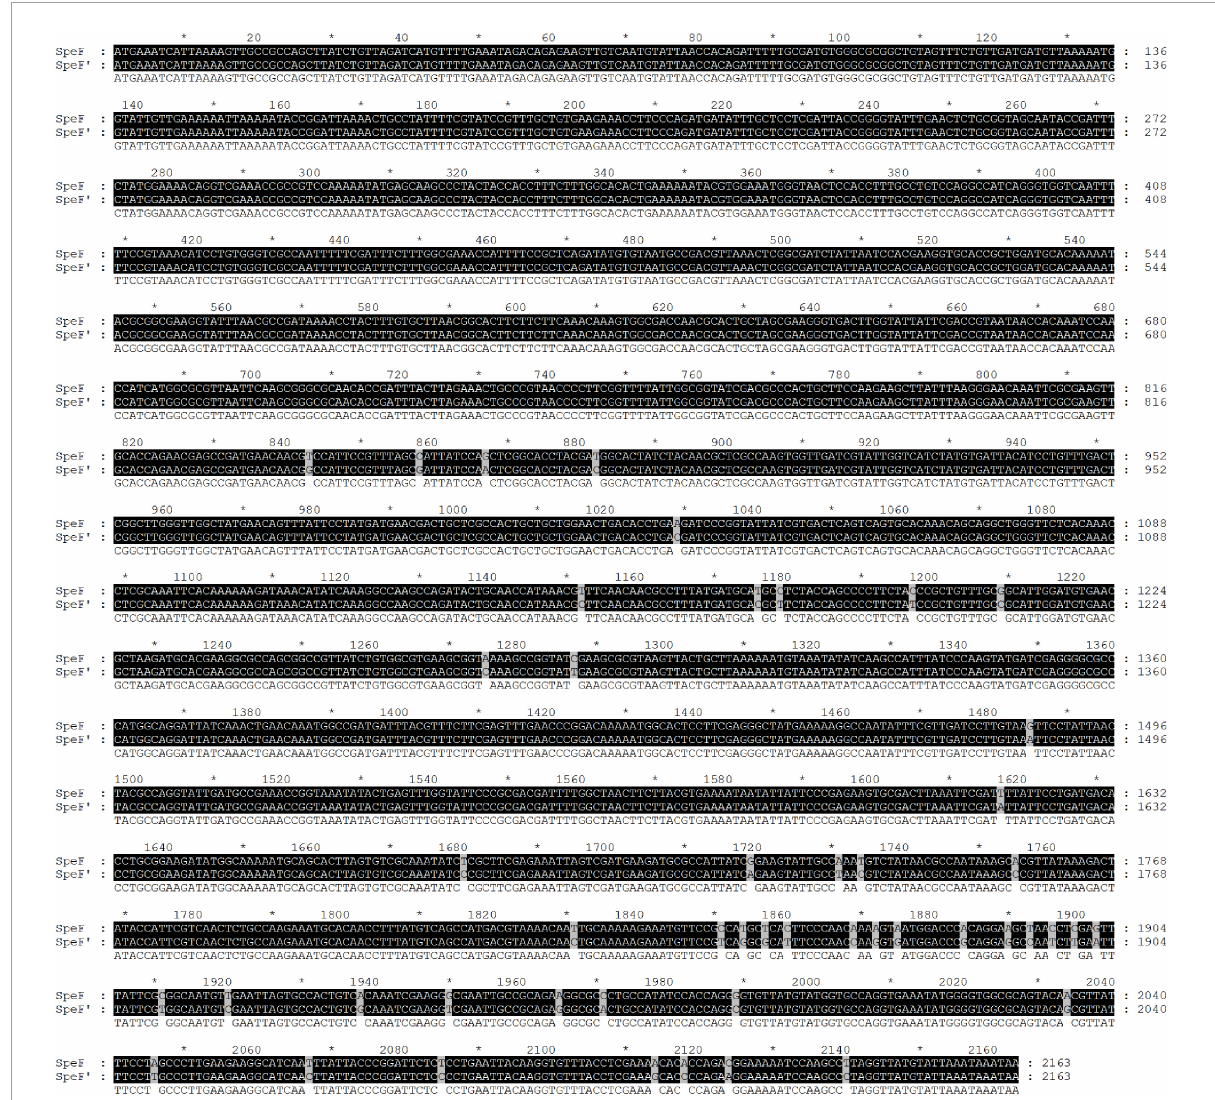
FIGURE2 Nucleotide sequence alignment of PCR product amplified by a wild strain of Shewanella xiamenensis , which was named as SpeF’, and ornithine decarboxylation gene from NCBI database, which was named as